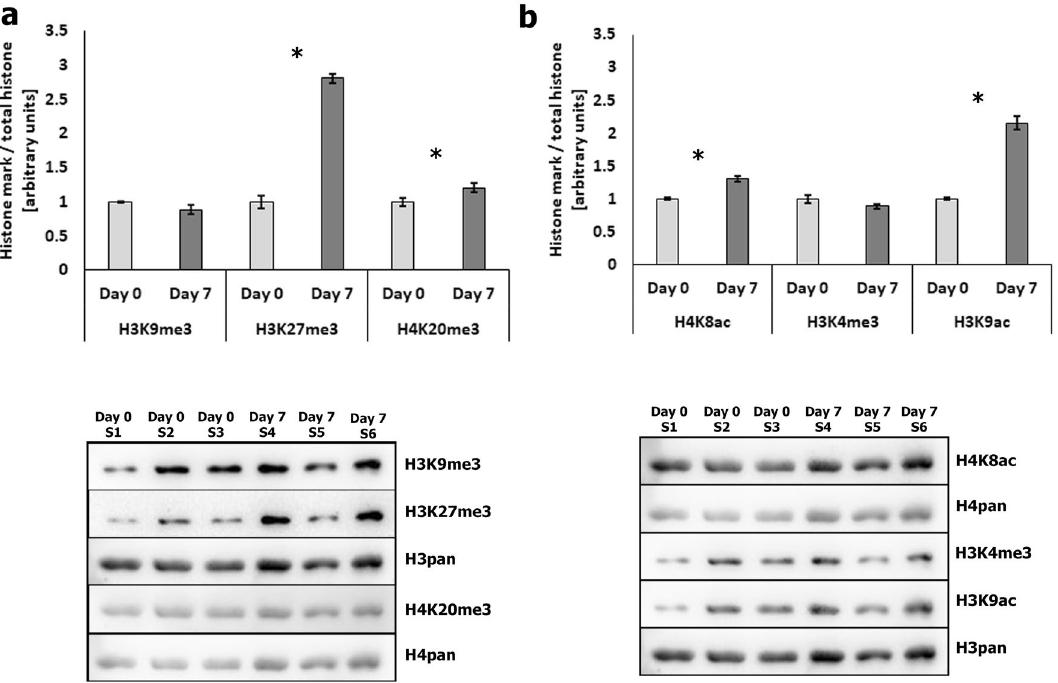
Figure 3. Western blot analysis of histone modification levels during adipogenesis. ( a ) The abundance of H3K9me3, H3K27me3, and H4K20me3 modifications in undifferentiated cells (day 0) and adipocytes (day 7). Statistically significant differences ( P < 0.05) are marked with asterisks. ( b ) Abundance of H4K8ac, H3K4me3, and H3K9ac histone modifications in undifferentiated cells (day 0) and adipocytes (day 7). Statistically significant differences ( P < 0.05) are marked with asterisks. Full length blots are presented in Supplementary Figures S4 and